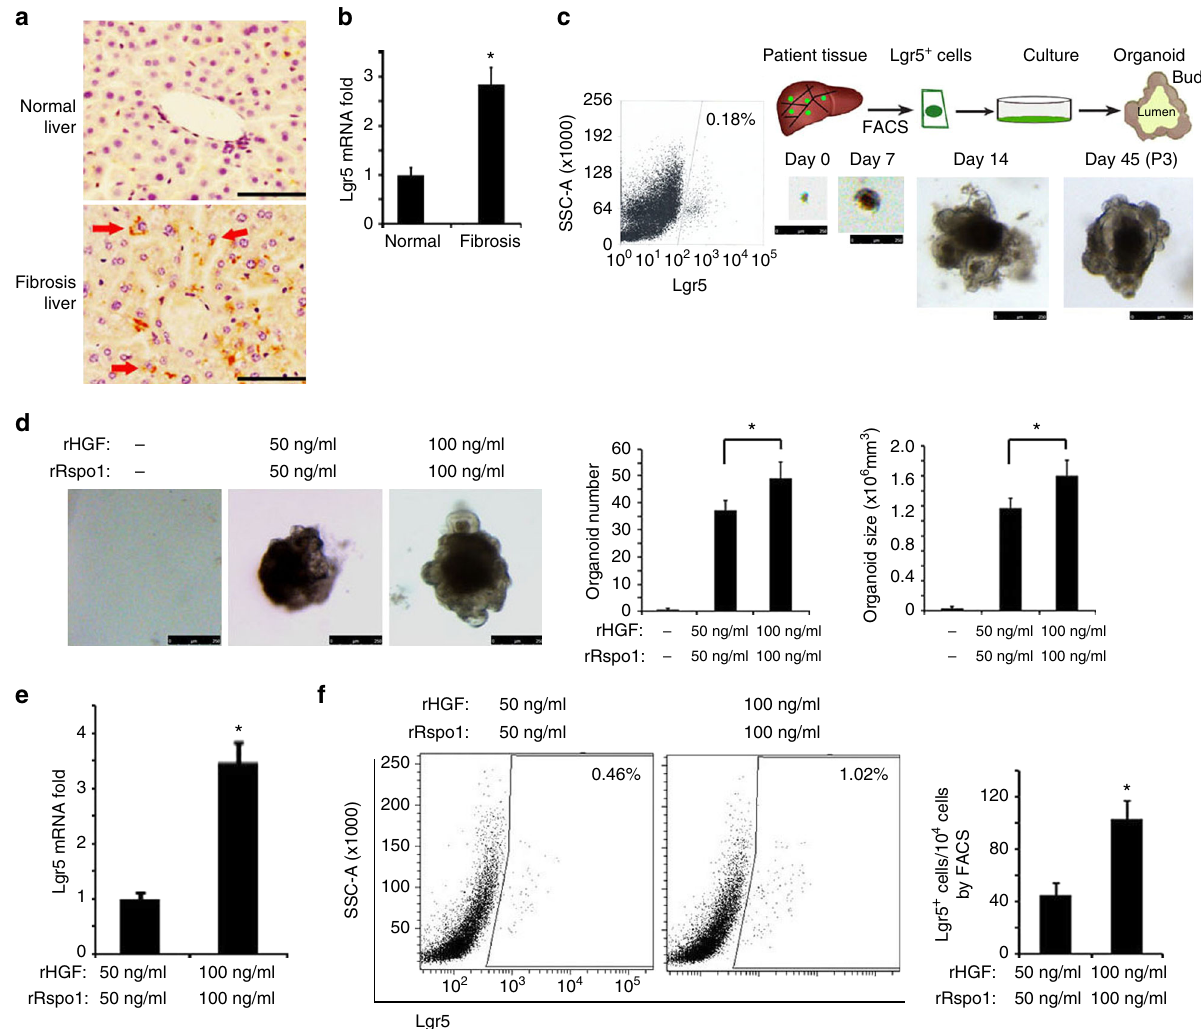
Fig. 5 Lgr5 + liver stem cells existed in human fi brotic livers. a Lgr5 staining in human liver samples using anti-Lgr5 antibody. b Lgr5 mRNA level in human liver samples. c FACS plot for human Lgr5 + liver cells (left) and a schematic overview of the experimental setup (top right). Single Lgr5 + cells were isolated from six independent donors human liver biopsies diagnosed with liver fi brosis, they were cultured for organoids formation, and continuously cultured for at least three passages in vitro. The representive images were shown (bottom right). d – f Single Lgr5 + cells were isolated from six independent donors human liver biopsies diagnosed with liver fi brosis and cultured, and different concentrations of rHGF/rRspo1 were added into the culture medium; the representative organoid pictures, organoids number, and organoids size were analyzed ( d ). The Lgr5 mRNA level in the organoids was measured using qPCR assay ( e ). The Lgr5 + cells numbers were measured using FACS assay ( f ). For a , e , triplicates for each condition were analyzed. The results are shown as mean ± s.d. of three independent experiments. * p < 0.05. For d , f , the results are shown as mean ± s.d. of three independent experiments. * p < 0.05. Scale bars, 200 μ m ( a ), 250 μ m ( c , d )